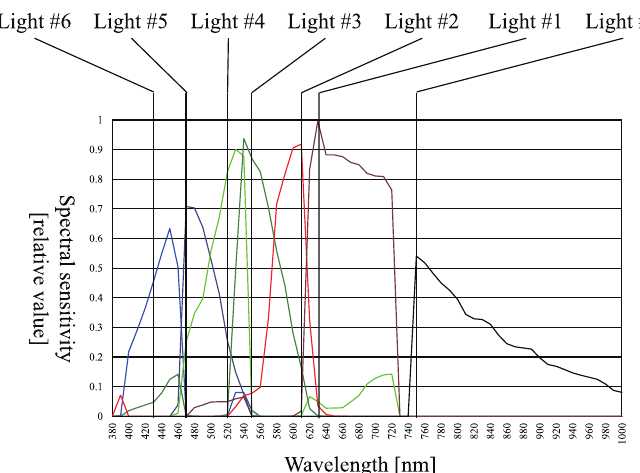
Figure 8. Spectral sensitivity of multispectral camera and peak wavelength of each light sources.